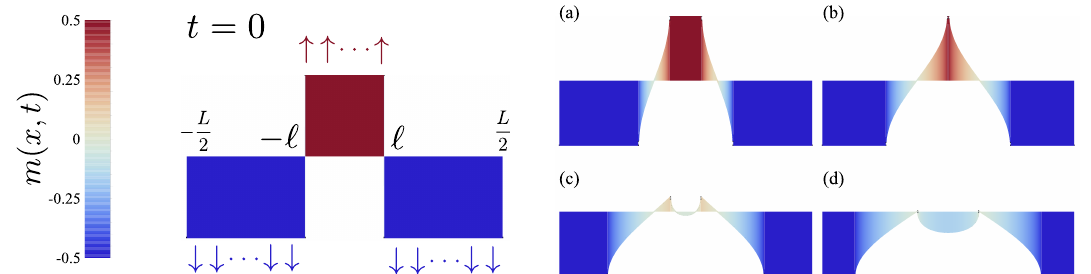
Figure 1: Illustration of the melting dynamics of the double domain wall state in Eq. (4). At t = 0 the system is prepared in the product state of three ordered domains, resulting into a step-like shape of the magnetization profile m ( x , t ) (left panel). (a) At early times, the central domain of aligned spin begins to melt into the left and right ferromagnets generating non-homogeneous propagation fronts around the junctions. After the initial transient regime, the two propagating fronts merge (b) and contribute together to the relaxation